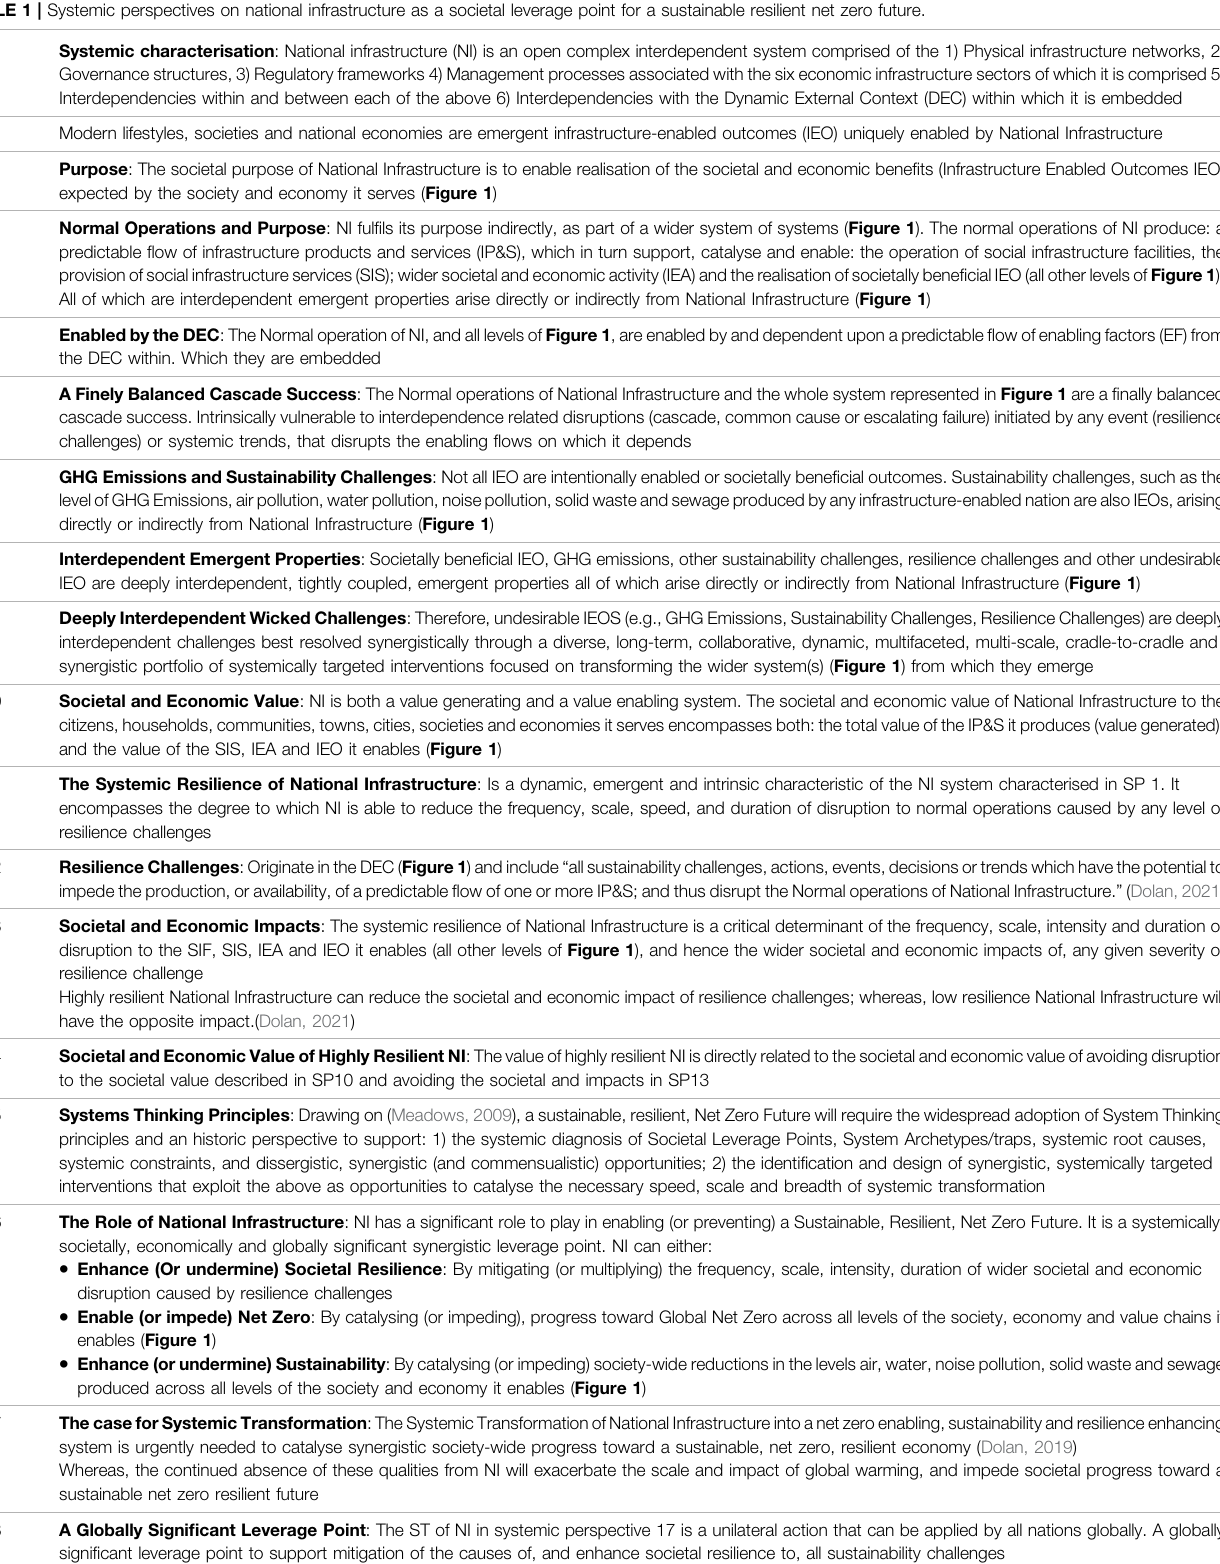
TABLE 1 | Systemic perspectives on national infrastructure as a societal leverage point for a sustainable resilient net zero